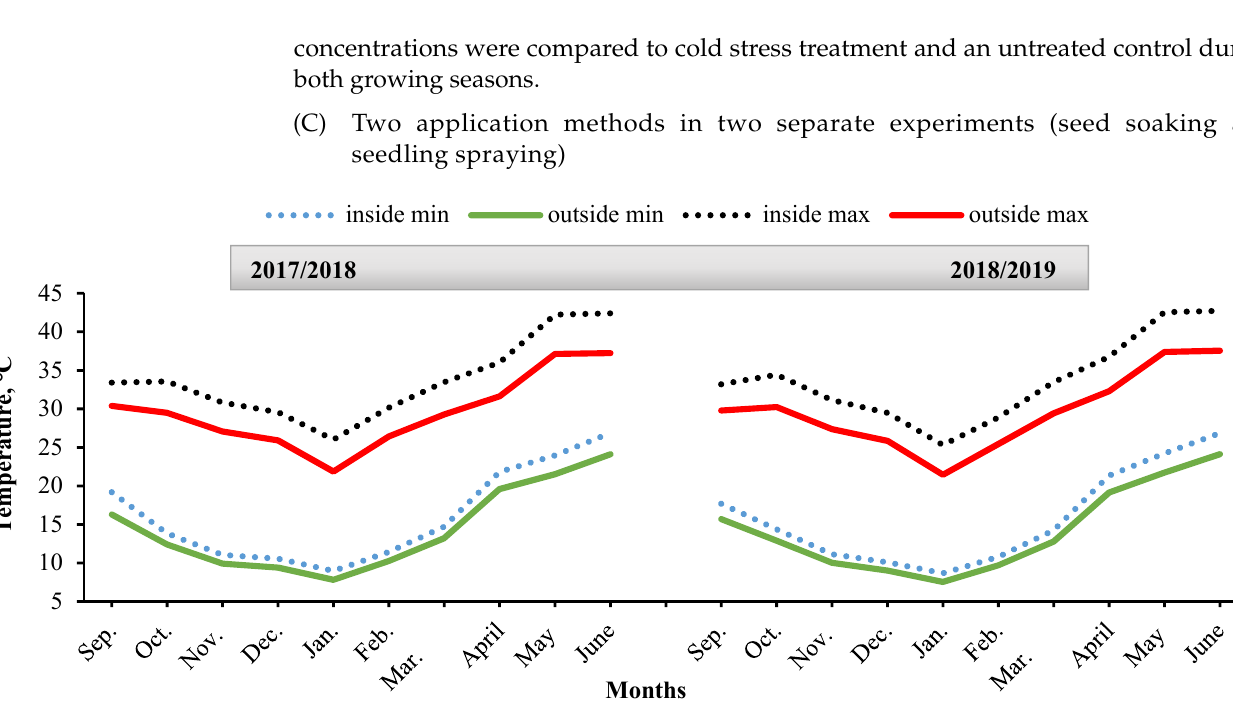
Figure 1. Maximum and minimum temperature for the inside and outside of the plastic greenhouse during the seasons of 2017/2018 and 2018/2019.